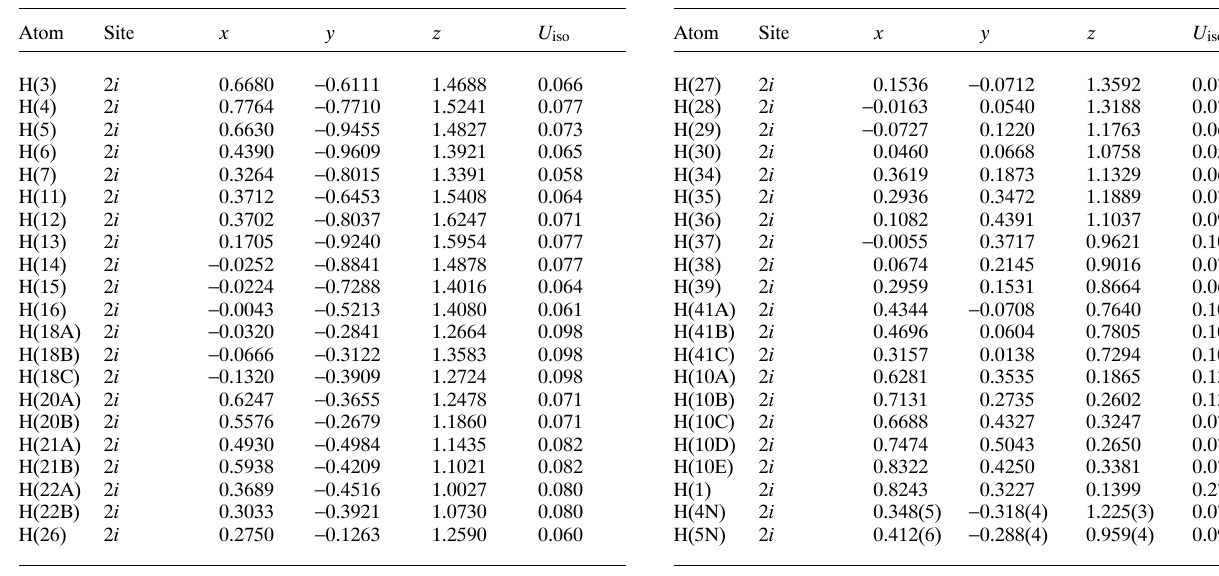
Table 2. A tomic coordin a tes a nd displ a cement p a r a meters (in Å 2 ) . Table 2. C ontinued